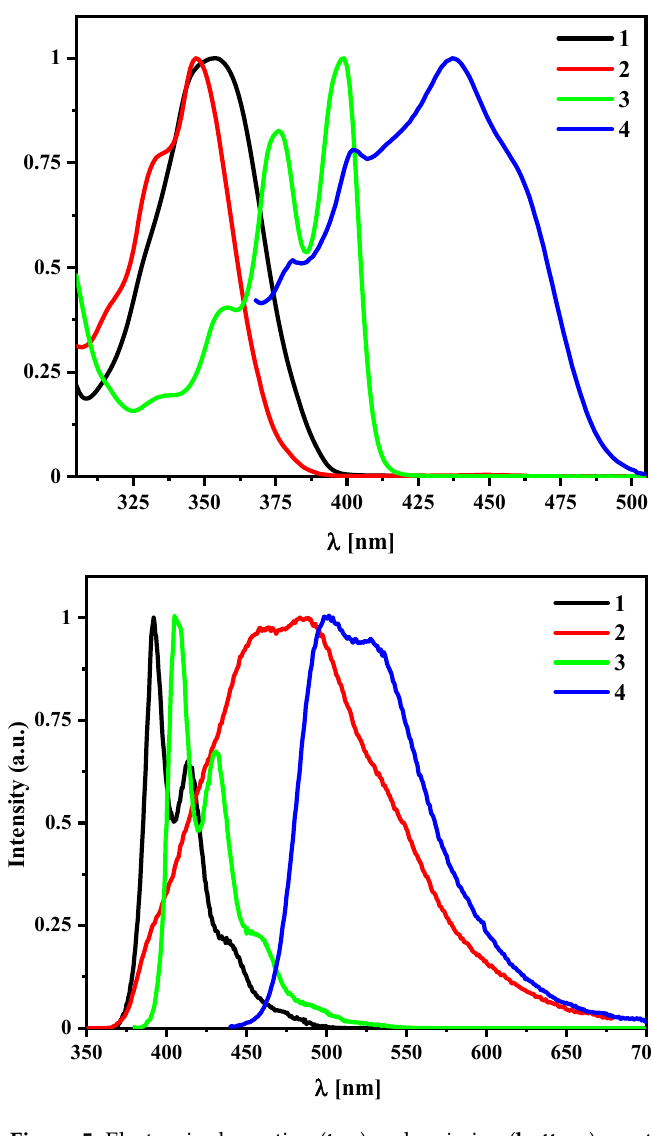
Figure 5. Electronic absorption ( top ) and emission ( bottom ) spectra of compounds 1 – 4 . Excitation at the maxima of absorption. Table 1. Photophysical data of compounds 1–4